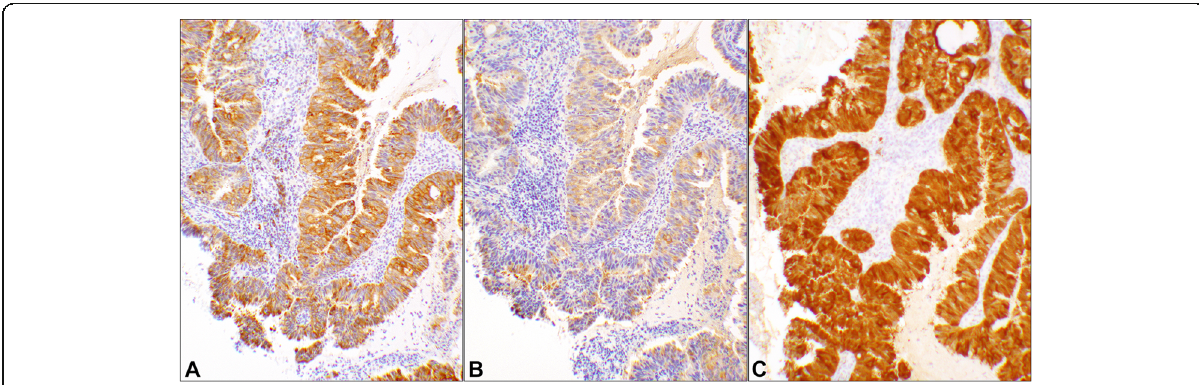
Fig. 4 Positive IHC reactivity in invasive endocervical adenocarcinoma, usual type. The three photomicrographs are obtained from a case of invasive adenocarcinoma of the endocervix (Case #41, Supplemental Table 1). A Stathmin-1, B HSP27, and C p16 positive immunostains in invasive endocervical adenocarcinoma. (Objective